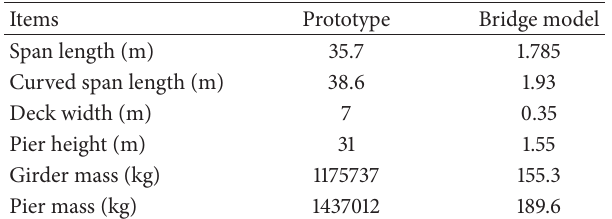
Figure 2: Loading and measurement of block. Table 2: Correspondences between the prototype and the bridge model.